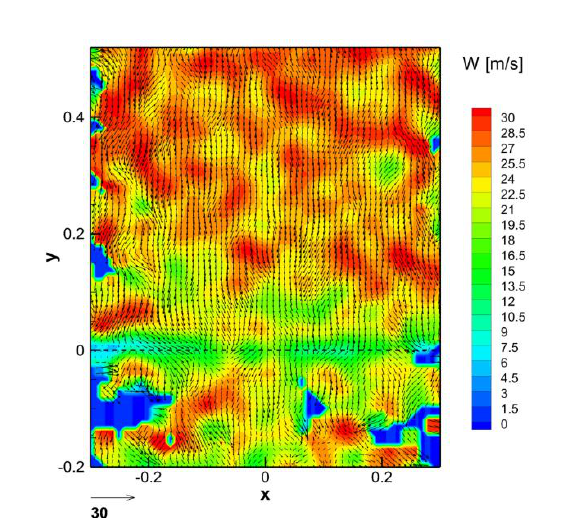
Fig. 9. Example of the instantaneous velocity field. Re = 1M.